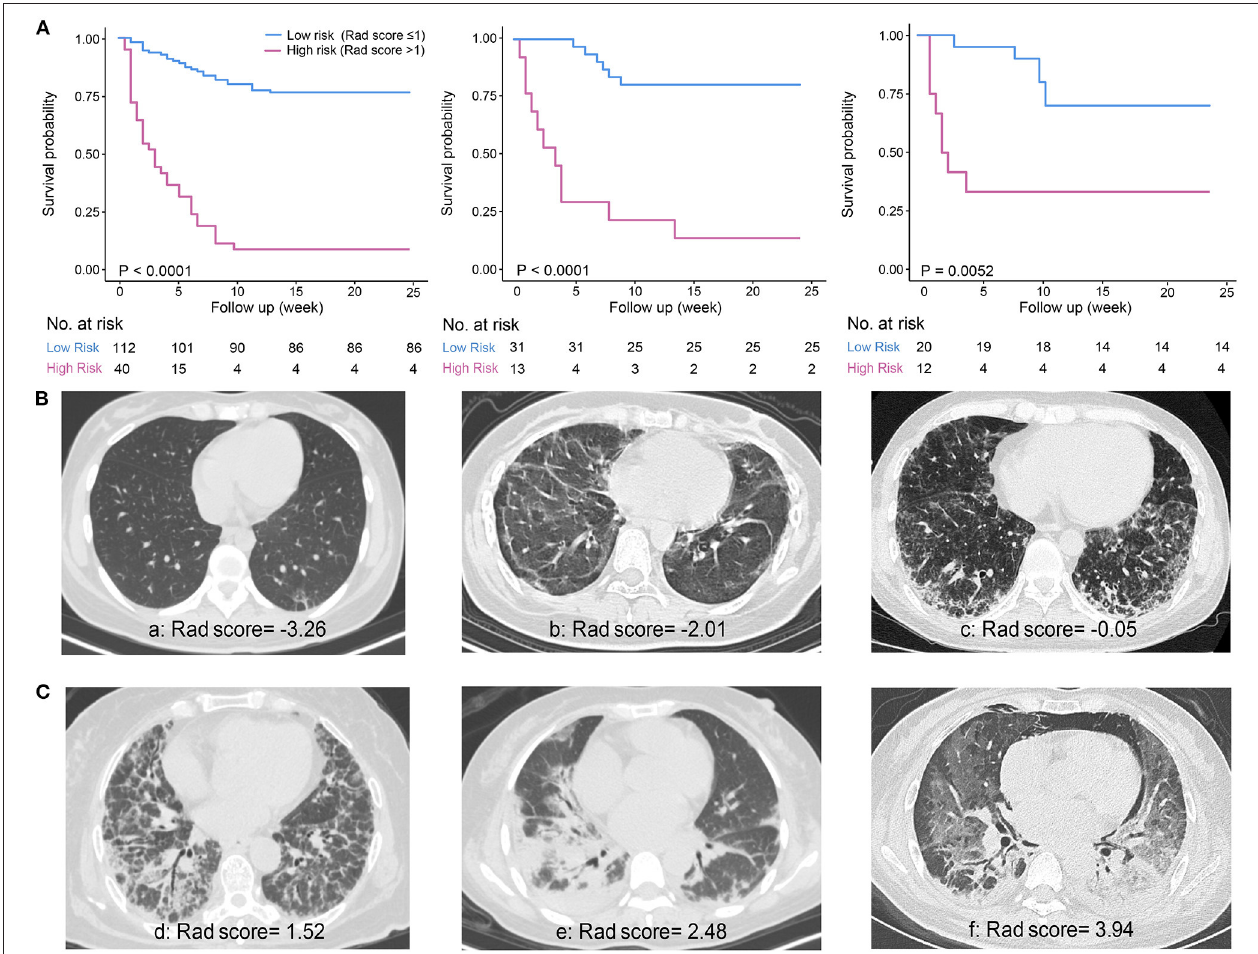
FIGURE 2 | Survival curves of the Rad-score and representative CT images. (A) Significant difference between low-risk (Rad-score ≤ 1) and high-risk (Rad-score > 1) groups was shown in the derivation cohort ( n = 152, left) and verified in the internal validation ( n = 44, middle) and external validation cohort ( n = 32, right). (B) Representative patients’ CT images of low-risk group. a: A 32-year-old female patient with discrete subpleural reticulation and ground-glass attenuation (GGA); b: a 23-year-old female patient with typical subpleural lines and GGA; c: a 39-year-old male patient showing a number of GGA and reticulation with some basal consolidation. (C) Representative patients’ CT images of high-risk group. d: A 62-year-old female patient with a large amount of reticulation pattern accompanied by GGA and consolidation; e: a 47-year-old female patient with predominant consolidation; f: a 41-year-old female patient with diffuse GGA and consolidation accompanied by